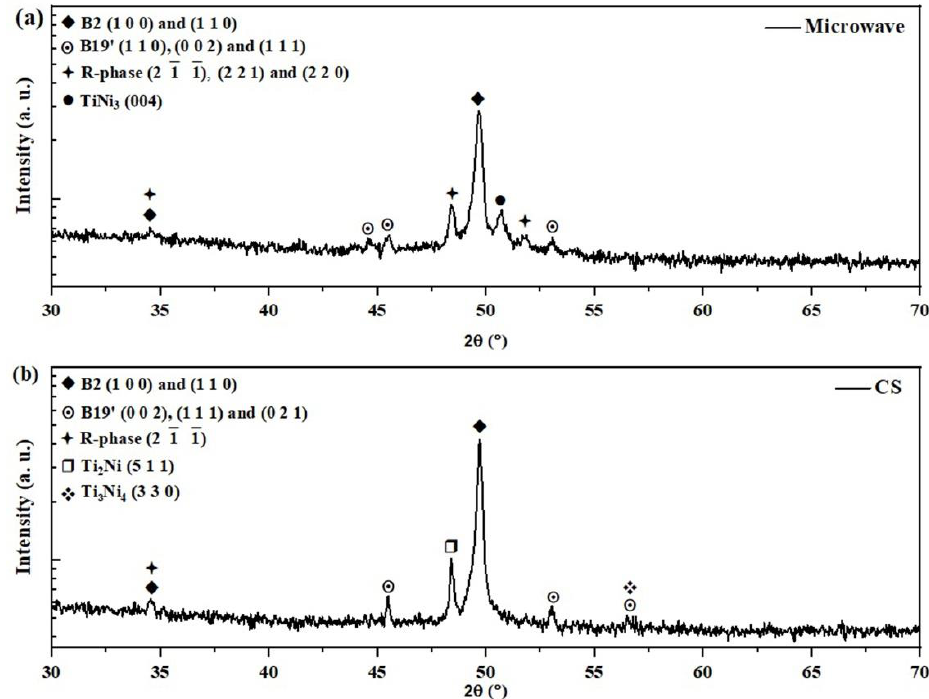
Figure 4. XRD patterns ( a ) MW and ( b ) CS sample.